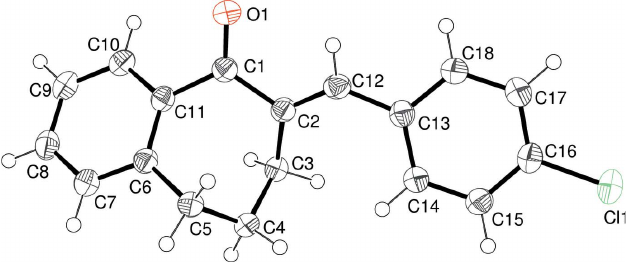
Figure 4 The molecular structure of (IV), showing 50% probability displacement ellipsoids.